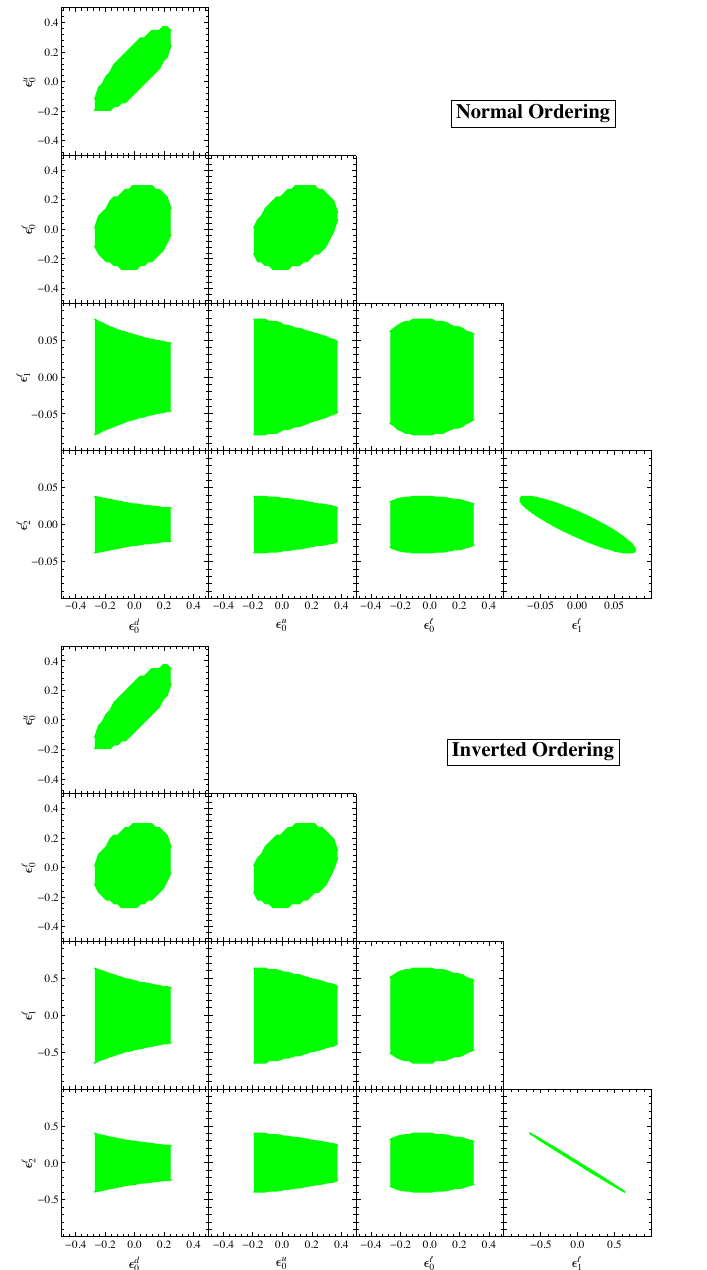
) at 90% CL in scenario II. Allowed regions in ; (cid:15) d ; (cid:15) ‘ ; (cid:15) ‘ ; (cid:15) ‘ 0 0 0 1 2